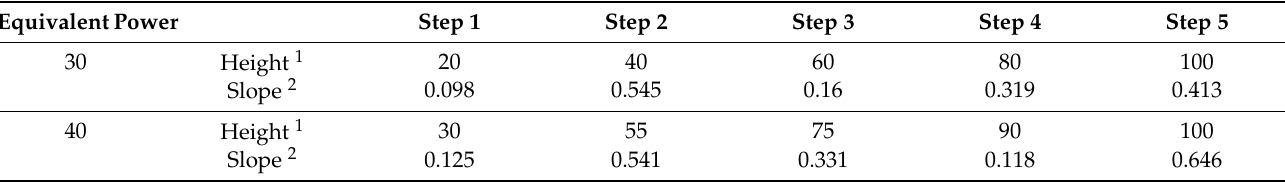
Table 2. Calibration slopes for the equivalent powers from 30% to 40%.